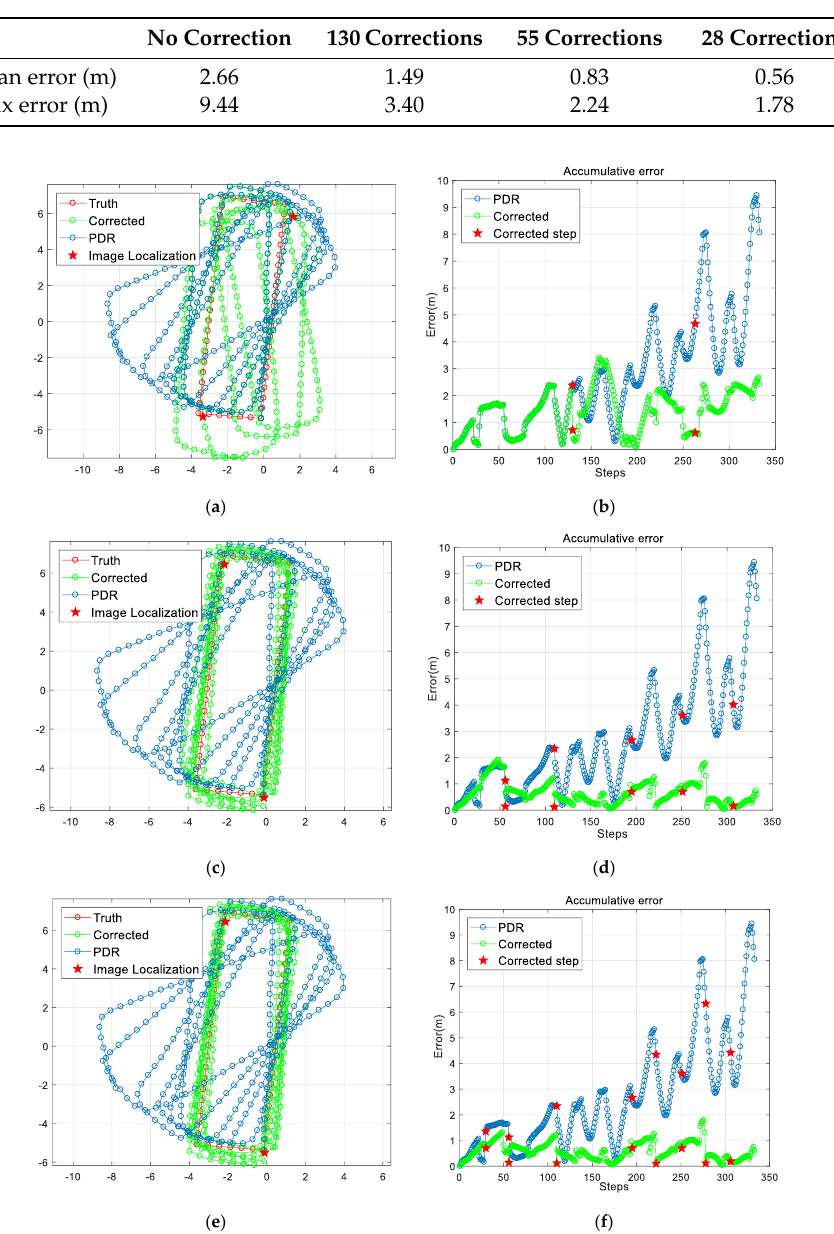
Figure 8. The results of the image localization aided pedestrian trajectory estimation: ( a , c , e ) are the estimated results when correcting the trajectory every 130 steps, every 55 steps and every 28 steps, respectively; ( b , d , f ) are the corresponding accumulative errors of ( a , c , e